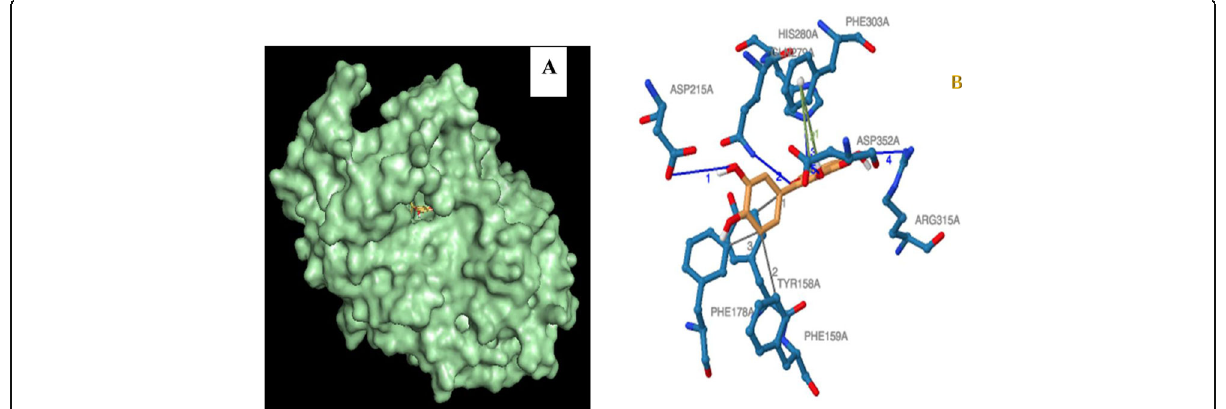
Fig. 5 Binding pose and binding site of quercetin with α -glucosidase (panel A), molecular interaction of quercetin with amino acid residues within the binding pocket of the protein structure (panel B)